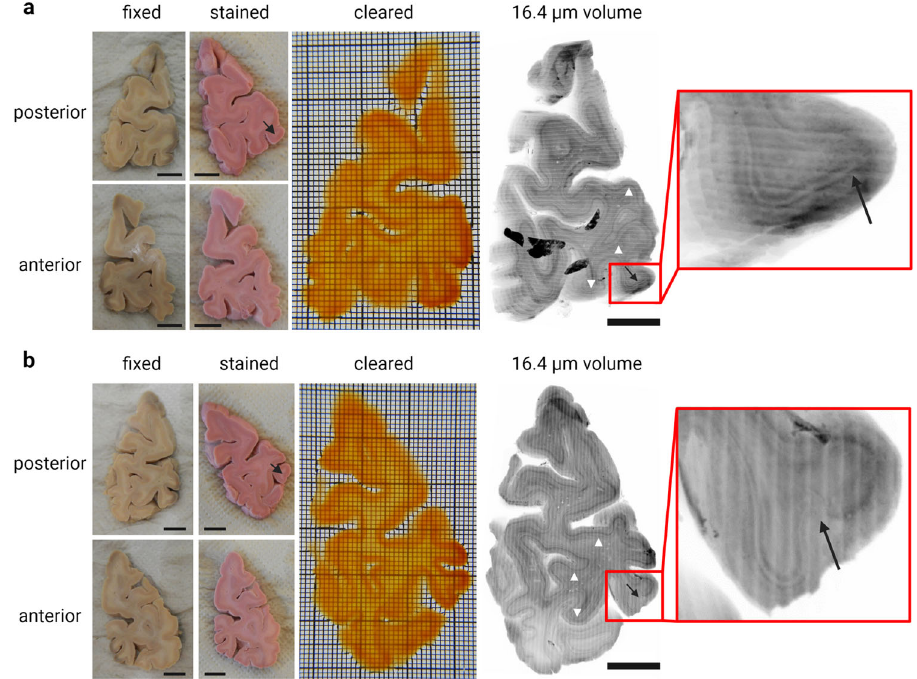
Fig. 1 MASH processing and Mosaic 16 acquisition of 3 mm thick human occipital lobe sections. a Sample taken approx. 6 mm anterior to occipital pole (third 3 mm thick section in posterior to anterior direction). From left to right: Formalin fi xed, unstained sample and MASH-NR stained sample from posterior and anterior side; cleared sample imaged from posterior side (the shape shows features of the transparent sample on both the anterior and posterior side; grid: smallest squares 1 × 1 mm, bold squares 10 × 10 mm). 3D reconstruction of the entire slice at 16.4 µ m isotropic resolution with a Mosaic 16 acquisition (scale bar: 1 cm): The densely stained cell-rich layers are recognisable even at low magni fi cation/large FOV overviews (white arrow heads). The V1/V2 border is indicated by the black arrows in the overview and the enlarged ROI. b Consecutive anterior slice of same occipital lobe approx. 9 mm anterior to occipital pole, panels as described for ( a ).